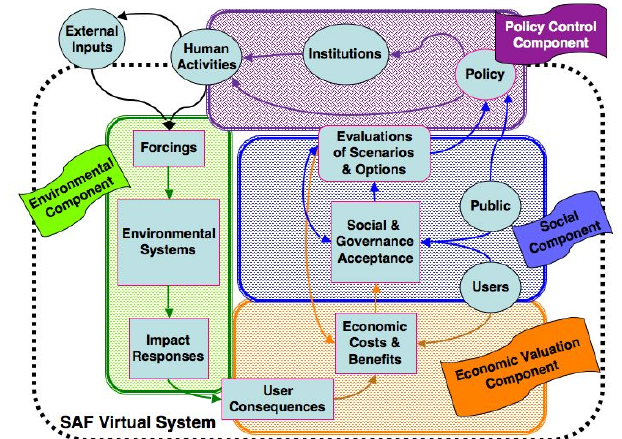
Fig. 3 . The SAF Virtual System domain with major Components and